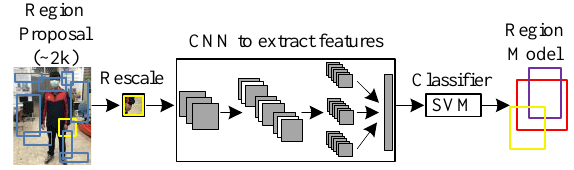
Figure 13. R-CNN architecture.